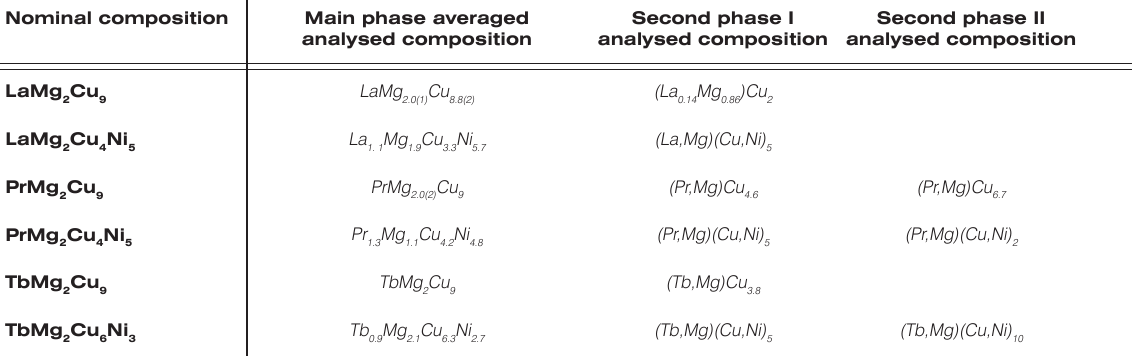
Table 1. Result of the EPMA analysis. Nominal